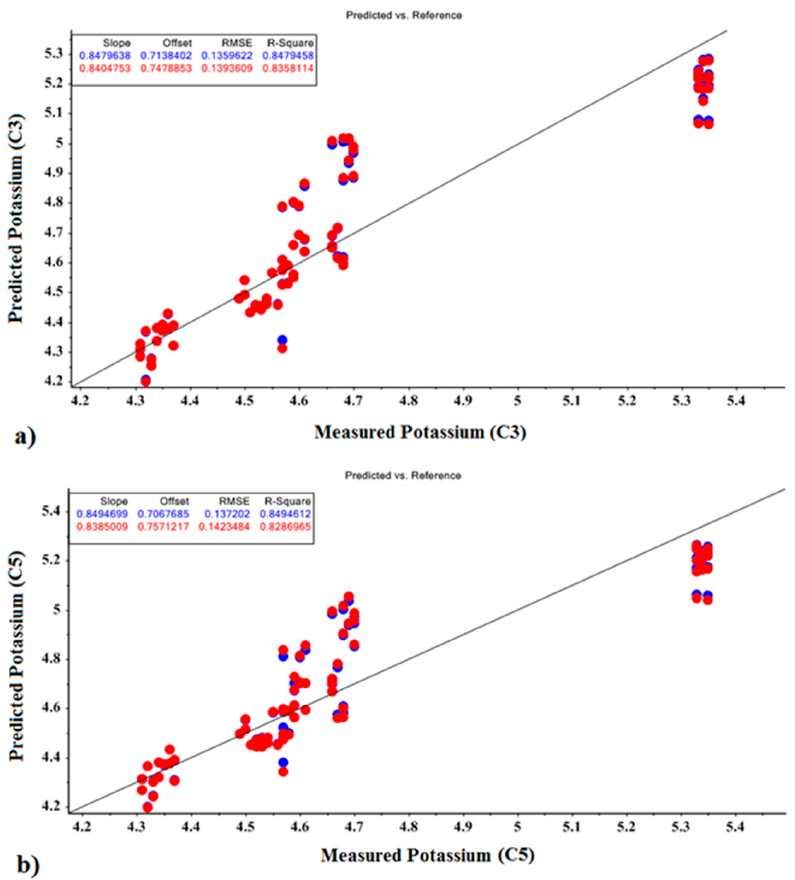
Figure 8. MLR prediction models for potassium fertilizer based on optimal factors of ( a ) PCR model and ( b ) PLSR model.